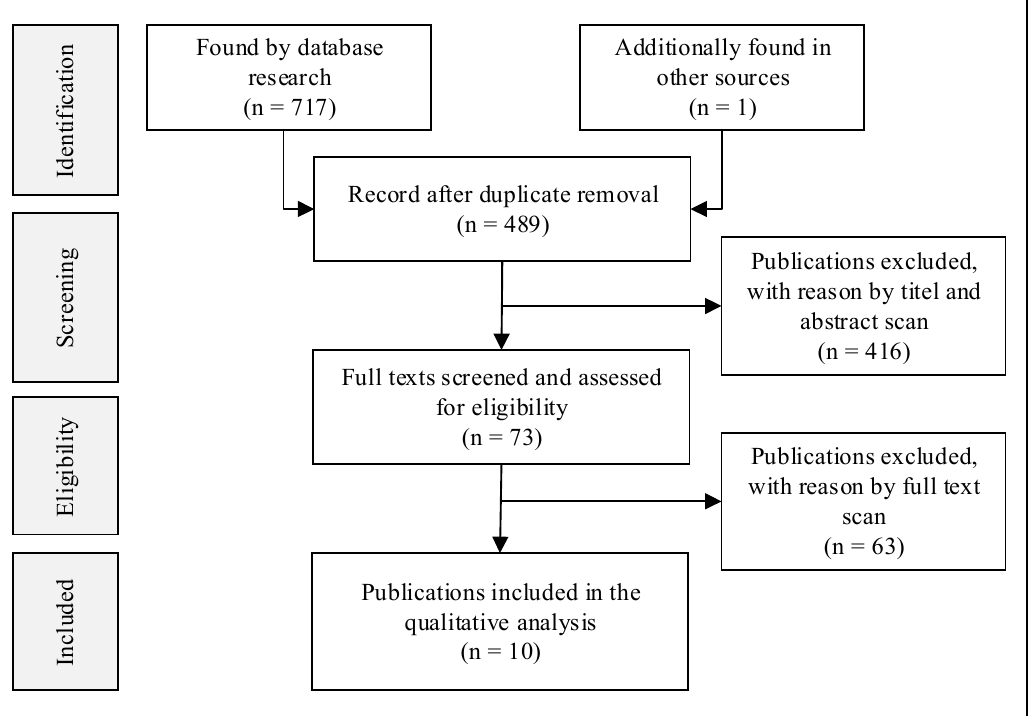
Figure 1. PRISMA flow diagram of included publications.